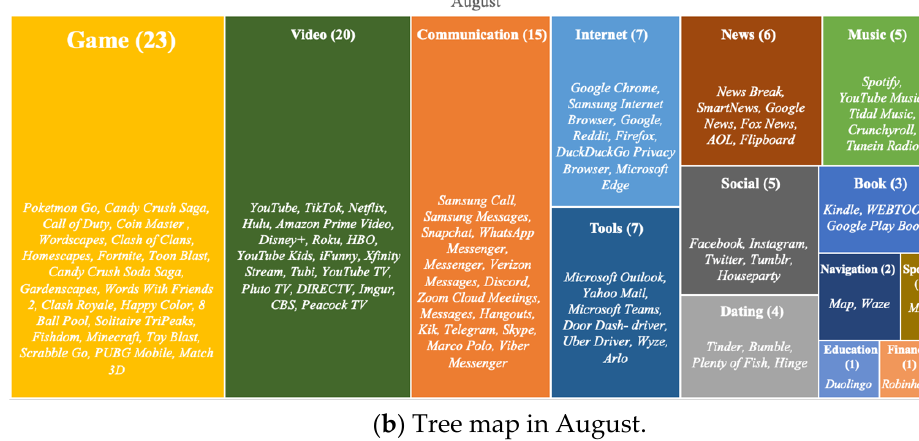
Figure 4. Tree map of ranking in January and August.